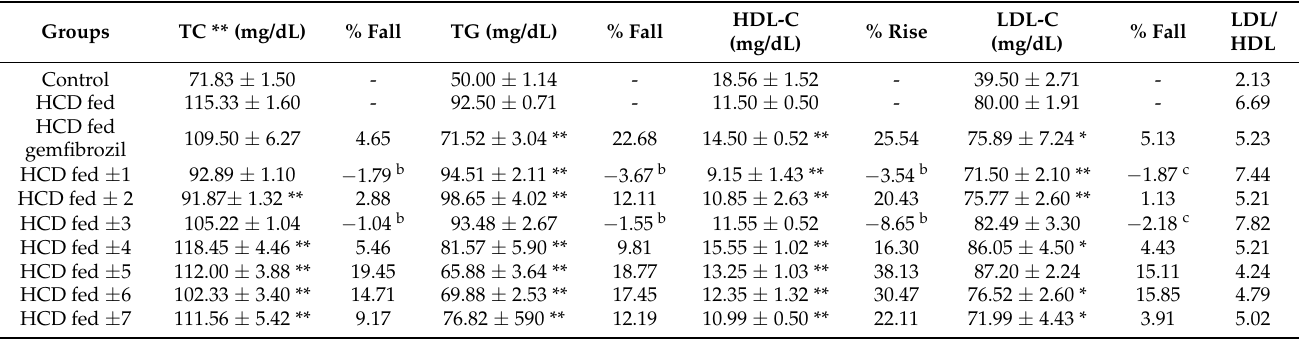
Table 1. Effect of tested compounds on lipid profile of hyperlipidemic